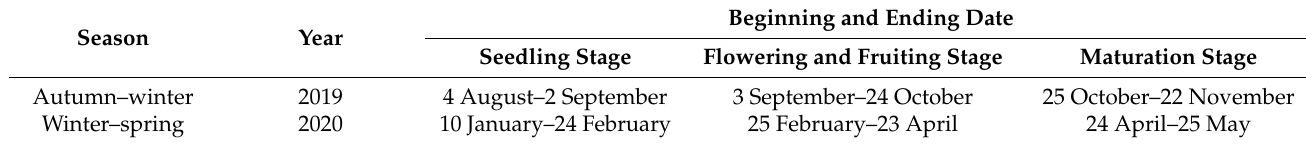
Table 2. Division of tomato growth periods in a solar greenhouse.